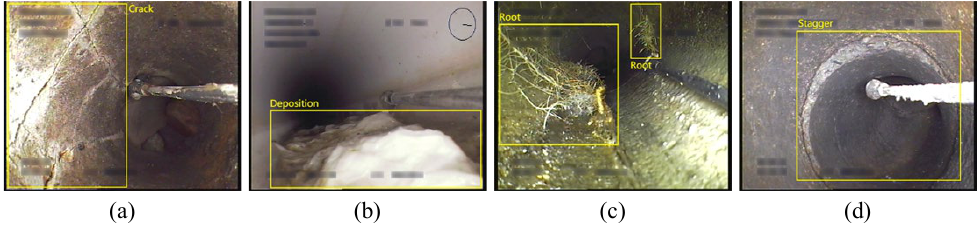
Figure 2. Raw sewer defect images: ( a ) crack; ( b ) deposition; ( c ) root; and ( d ) stagger.